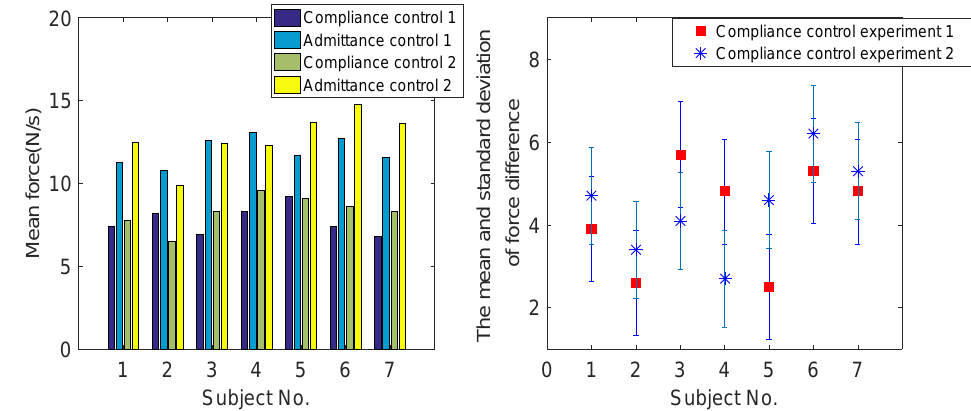
Figure 11. The mean interactive force and the standard deviation of the interactive force difference of seven subjects. The red box is the standard deviation of interactive force in Compliance Control Experiment I. The blue ∗ is the standard deviation of interactive force in Compliance Control Experiment II.